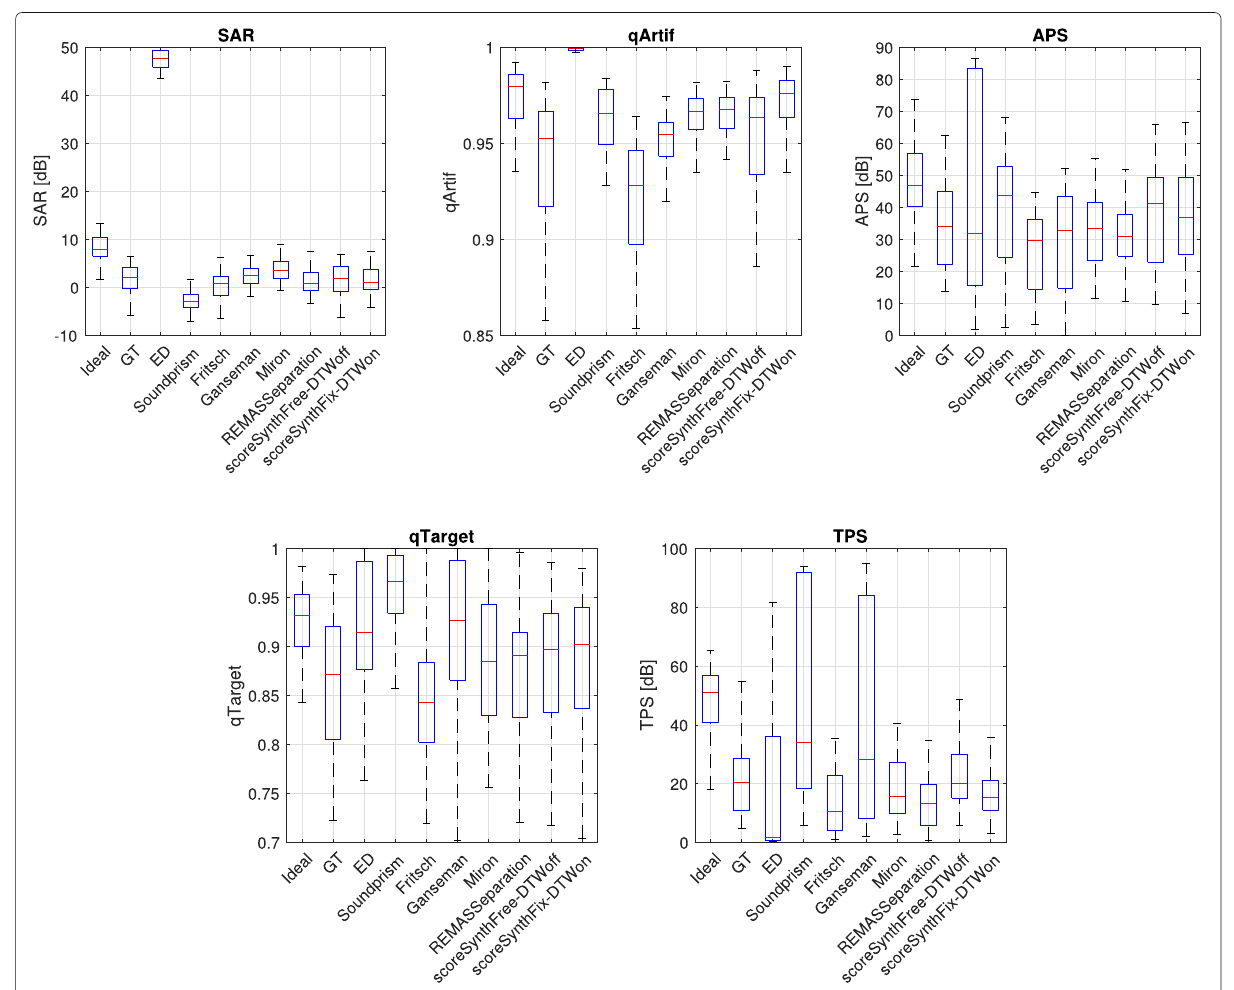
Fig. 14 Additional objective and perceptual measures for Fig.